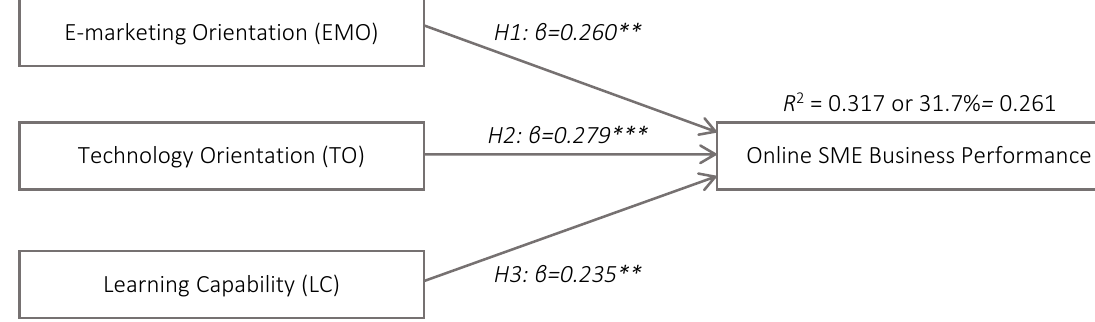
Figure 2. Result analysis of regression